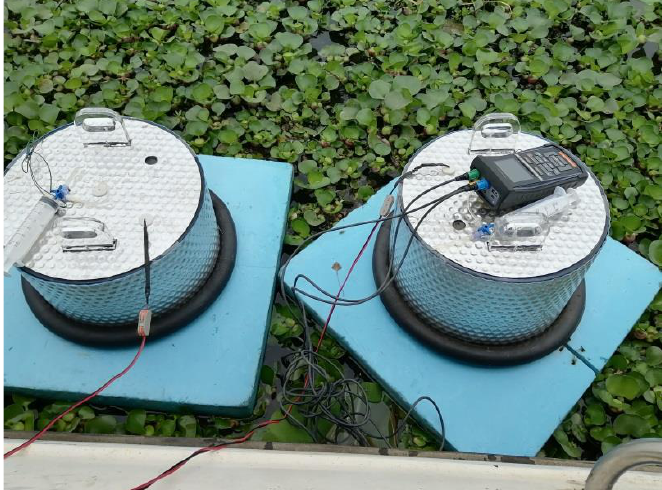
Figure 2. The measuring chambers at the invasive water hyacinth site (ECs) of Hong Lake.